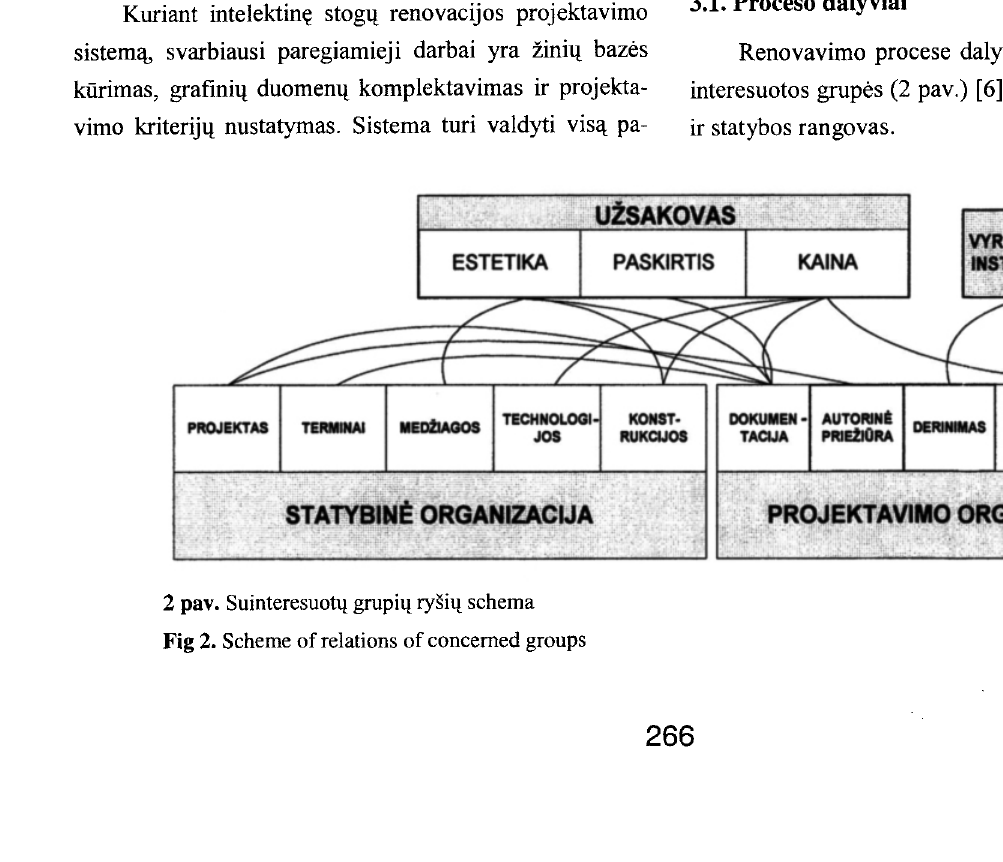
Fig 2. Scheme of relations of concerned